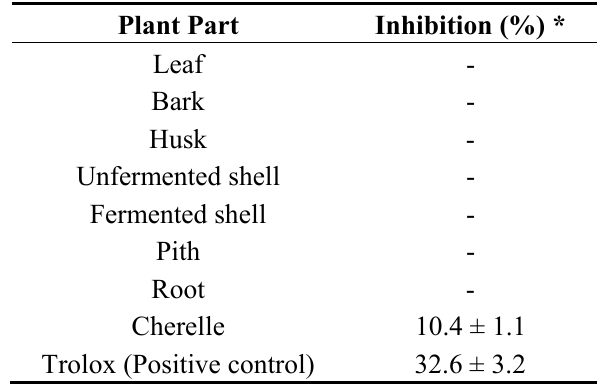
Table 3. Lipid peroxidation activity of cocoa plant part